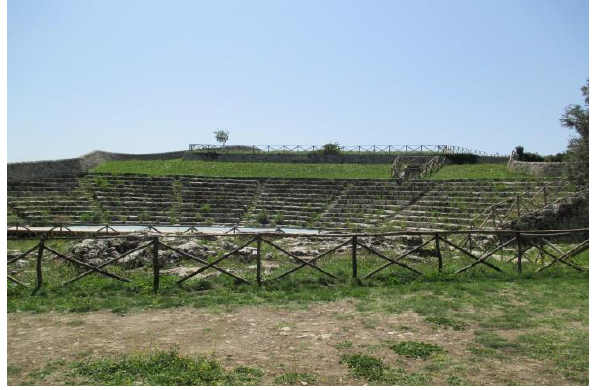
Figure 1 - il Teatro di Palazzolo Acreide